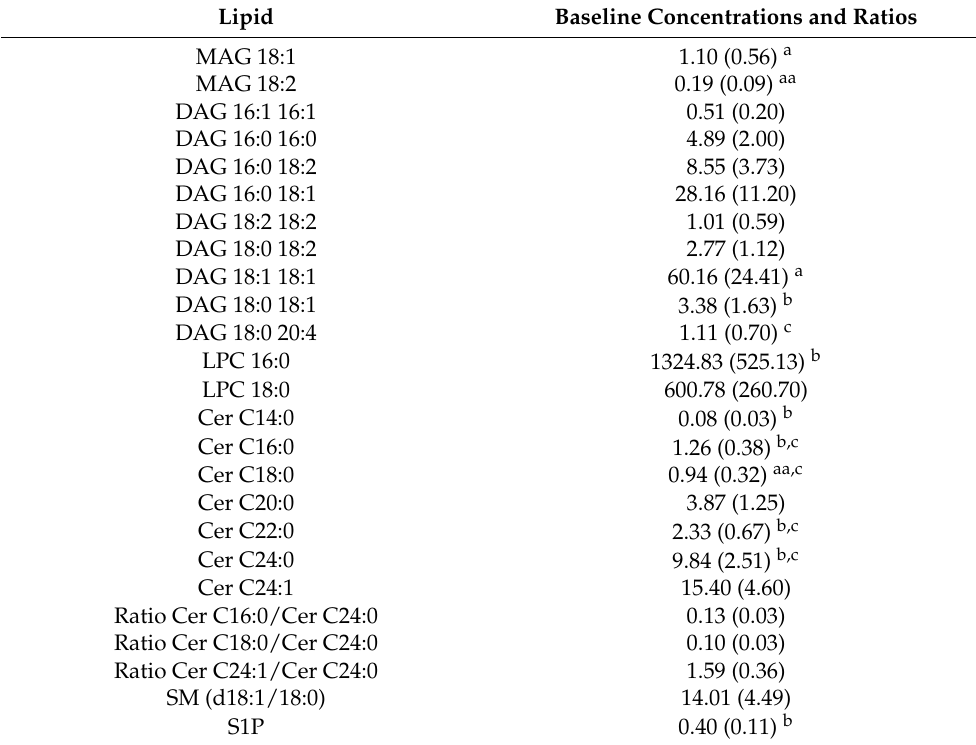
Table A2. Baseline lipidomic profile.